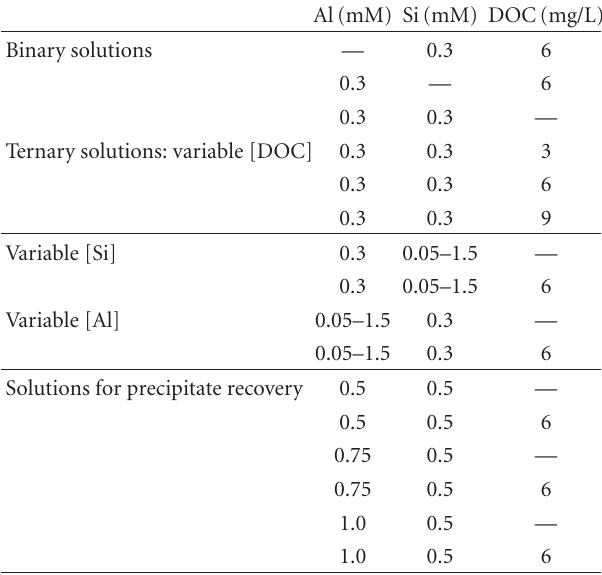
Table 1: Concentrations of Al, Si, and DOC used for binary and ternary experiments (variable [DOC]), variables [Si] and [Al], and experiments used to generate precipitates for further